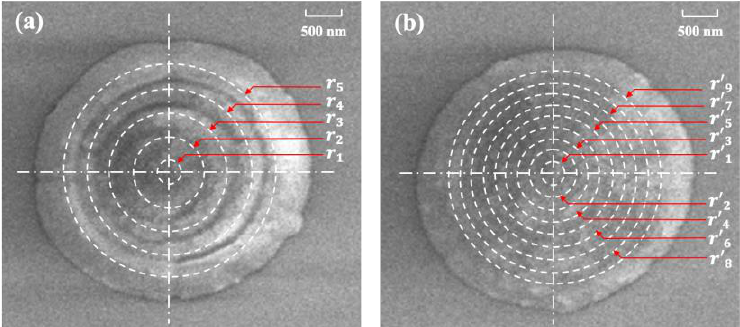
Figure 9. Fabrication of a solid structure by diminishing contours with SVG-guided SLM LDW. Circular structure fabricated by ( a ) 5 and ( b ) 9 diminishing contours.